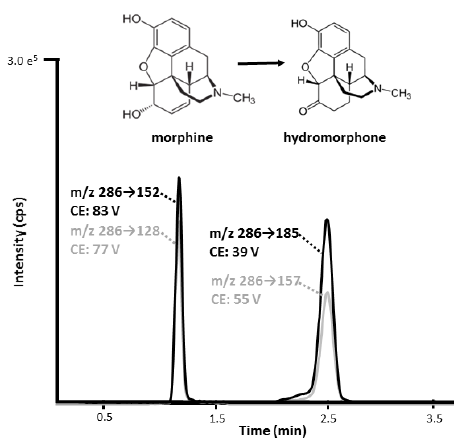
Figure 3. LC-MS/MS chromatogram of morphine and hydromorphone with their respective multiple reaction monitoring (MRM) transition and collision energy (CE). Quantifier and qualifier MRM transitions are marked in black and gray, respectively.